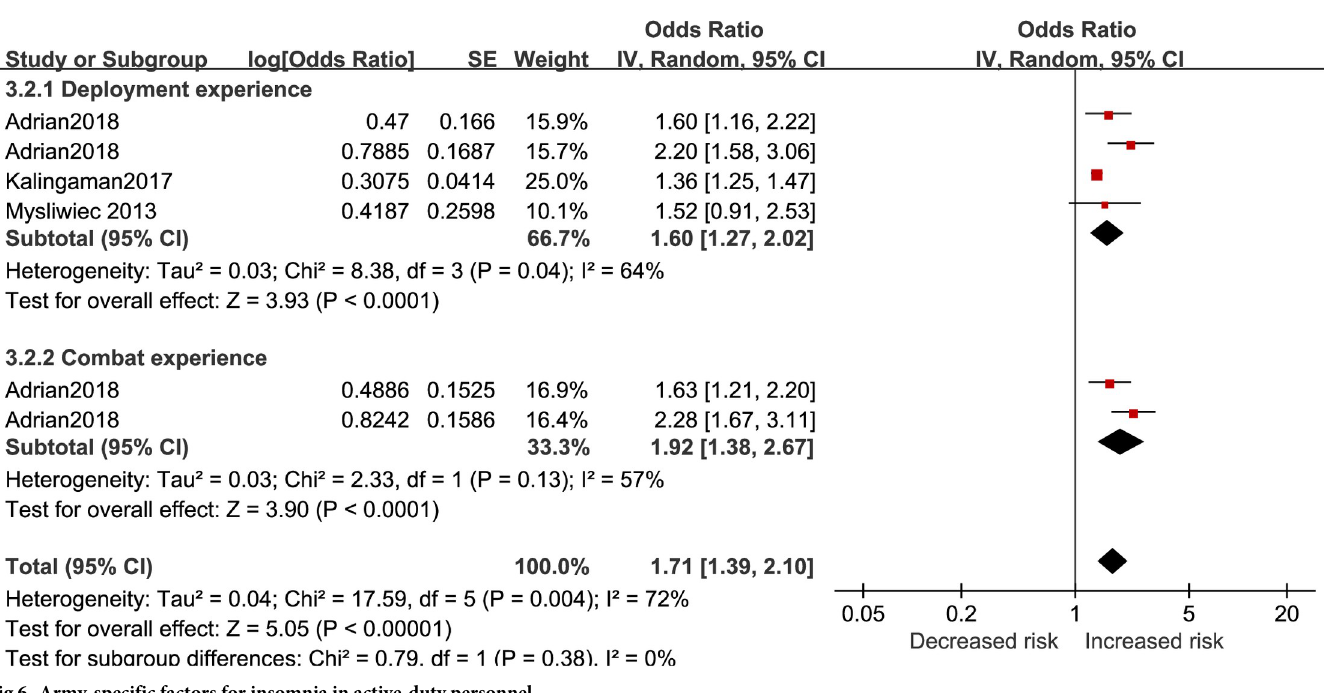
Fig 6. Army-specific factors for insomnia in active-duty